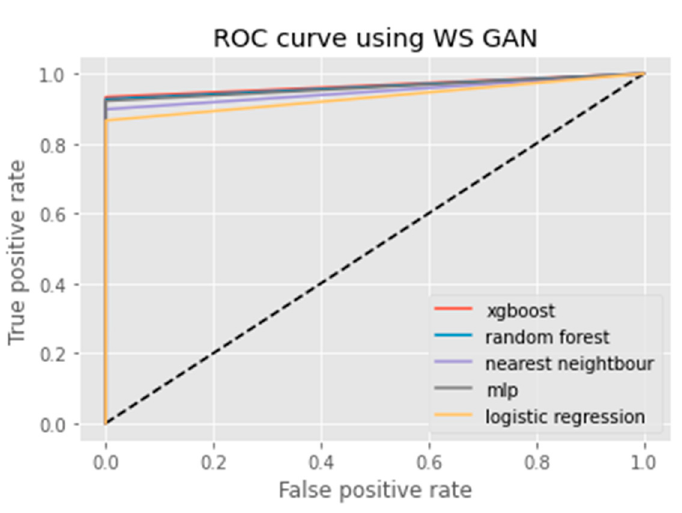
Figure 7. ROC curve using Vanilla GAN.